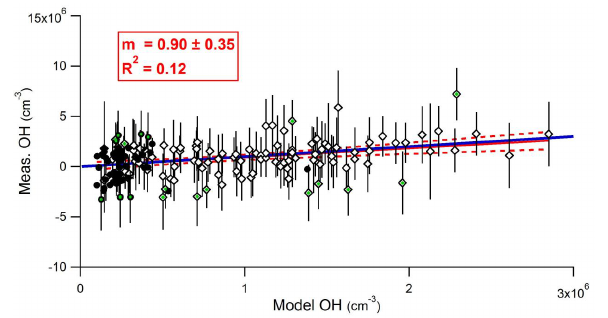
Figure 6: OH correlation plot for CABINEX 2009 (filled circles = nighttime, open diamonds = daytime) showing 2 hour median values. Vertical error bars are 2σ precision values on the measurements. The CABINEX 2σ model uncertainty (40%) is excluded. Green points are significantly (2σ) outside of the error bar range. Nighttime points within the 2σ uncertainty do not have their precision values shown. The blue line is a 1:1 correlation line and the solid red line shows a measurement vs. model regression of the data weighted by the precision in the measurements and the uncertainty of the model concentrations (slope = 0.90 ± 0.35), with dashed red lines representing the 95% confidence limits of the slope.